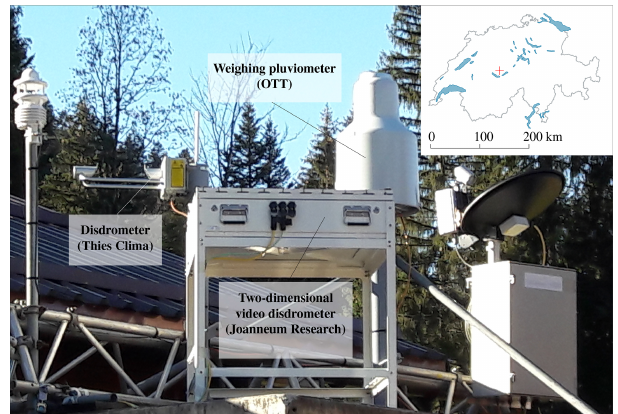
Figure 1. Measurement devices located in a pre-alpine area in Switzerland (Innereriz, 1060ma.s.l.). In this study, the Thies dis- drometer is evaluated using both the OTT pluviometer as well as a two-dimensional video disdrometer as a reference during 2 years of